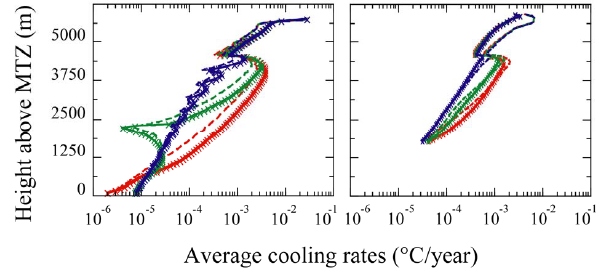
Fig. 6. Average cooling rates (ACR) calculated from Eq. 15 using two temperature intervals. The first, from 1275 to 1125°C, covers most of our crystallization range (left panel) the second, from 1050 to 850°C involves mainly sub-solidus temperatures (right panel). The vertical coordinate corresponds to the final depths reached by the tracers at the end of computation. ACR curves are drawn for the G (red curves), M (green curves) and S (blue curves) crustal accretion modes. In each panel, heavy solid lines correspond to cases with two orders of magnitude viscosity contrasts and high cracking temperature (1000 °C). The cases obtained by changing the viscosity contrasts superimpose perfectly (X symbols). Finally, the results obtained with an intermediate hydrothermal cracking temperature of 700 °C are displayed with dashed line.